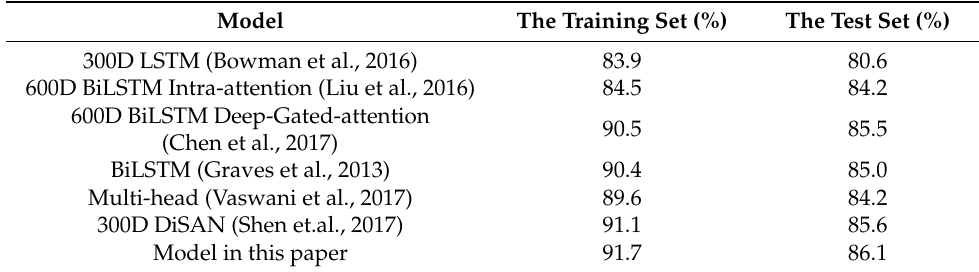
Table 3. Accuracy of various models in SNLI dataset.